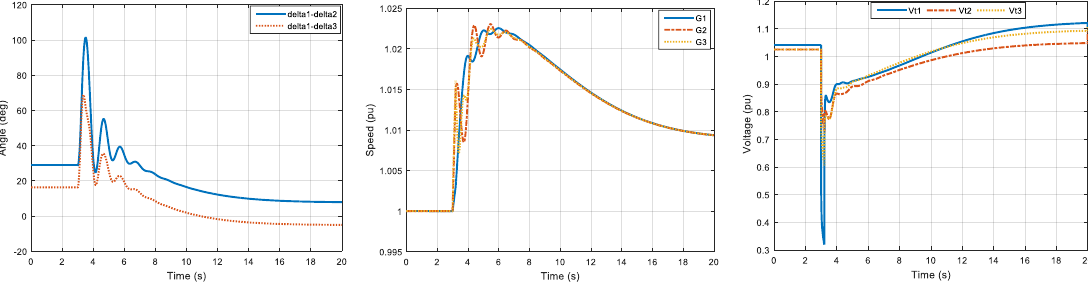
Fig.4 . Simulation results without integration of wind turbine